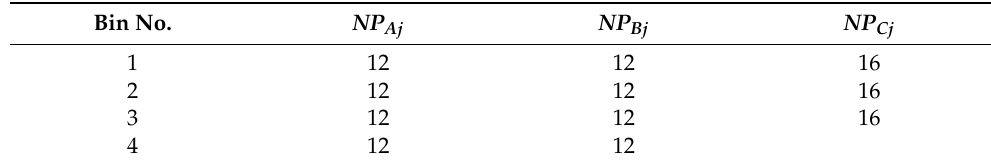
Table 2. Number of parts in each bin. Bin No. NP Aj NP Bj NP Cj 1 12 12 16 2 12 12 16 3 12 12 16 4 12